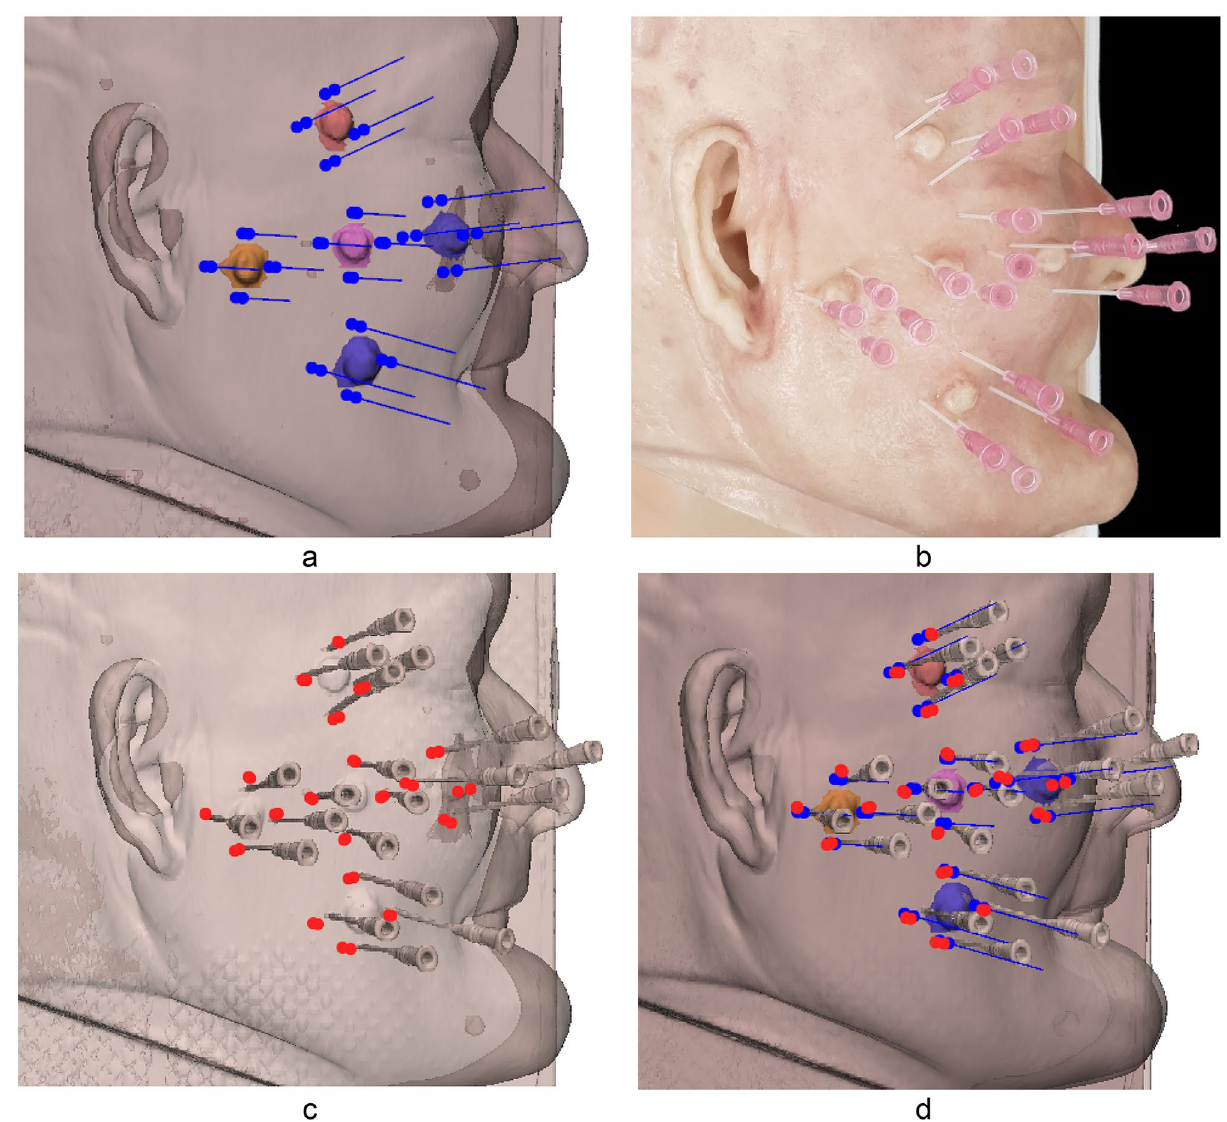
Figure 2. Visualization of the planned resection point using in-vitro phantom CT image and inserted 16 cc intravenous (IV) catheter into in-vitro phantom using skin cancer resection guide and matching planned points with actual inserted points. ( a ) Planned insertion points and line. ( b ) Inserted 16 cc IV catheters into in-vitro phantom using skin cancer resection guide. ( c ) Actual insertion points of 16 cc IV catheter. ( d ) Matching planned points with actual inserted